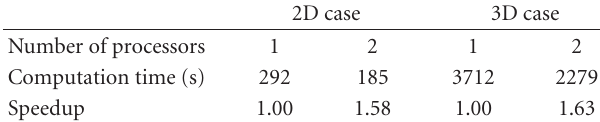
Table 5: E ffi ciency analysis of parallel computing strategy. 2D